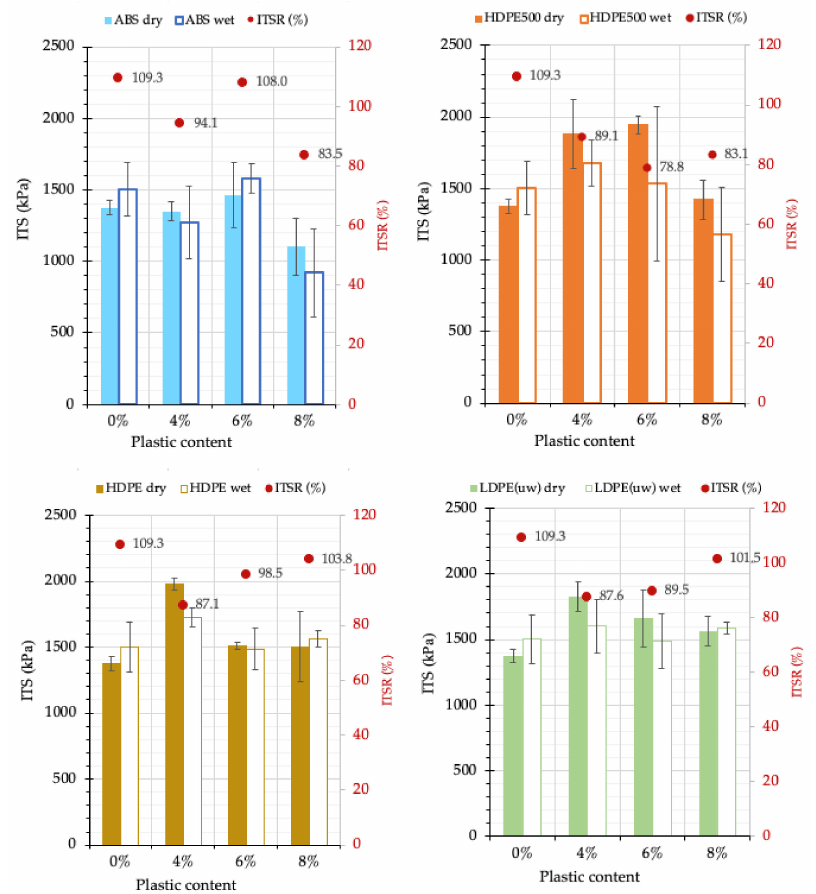
Figure 9. Indirect tensile strength (ITS) in dry conditions and ratio between ITS measured on wet and dry specimens (ITSR) as a function of plastic waste